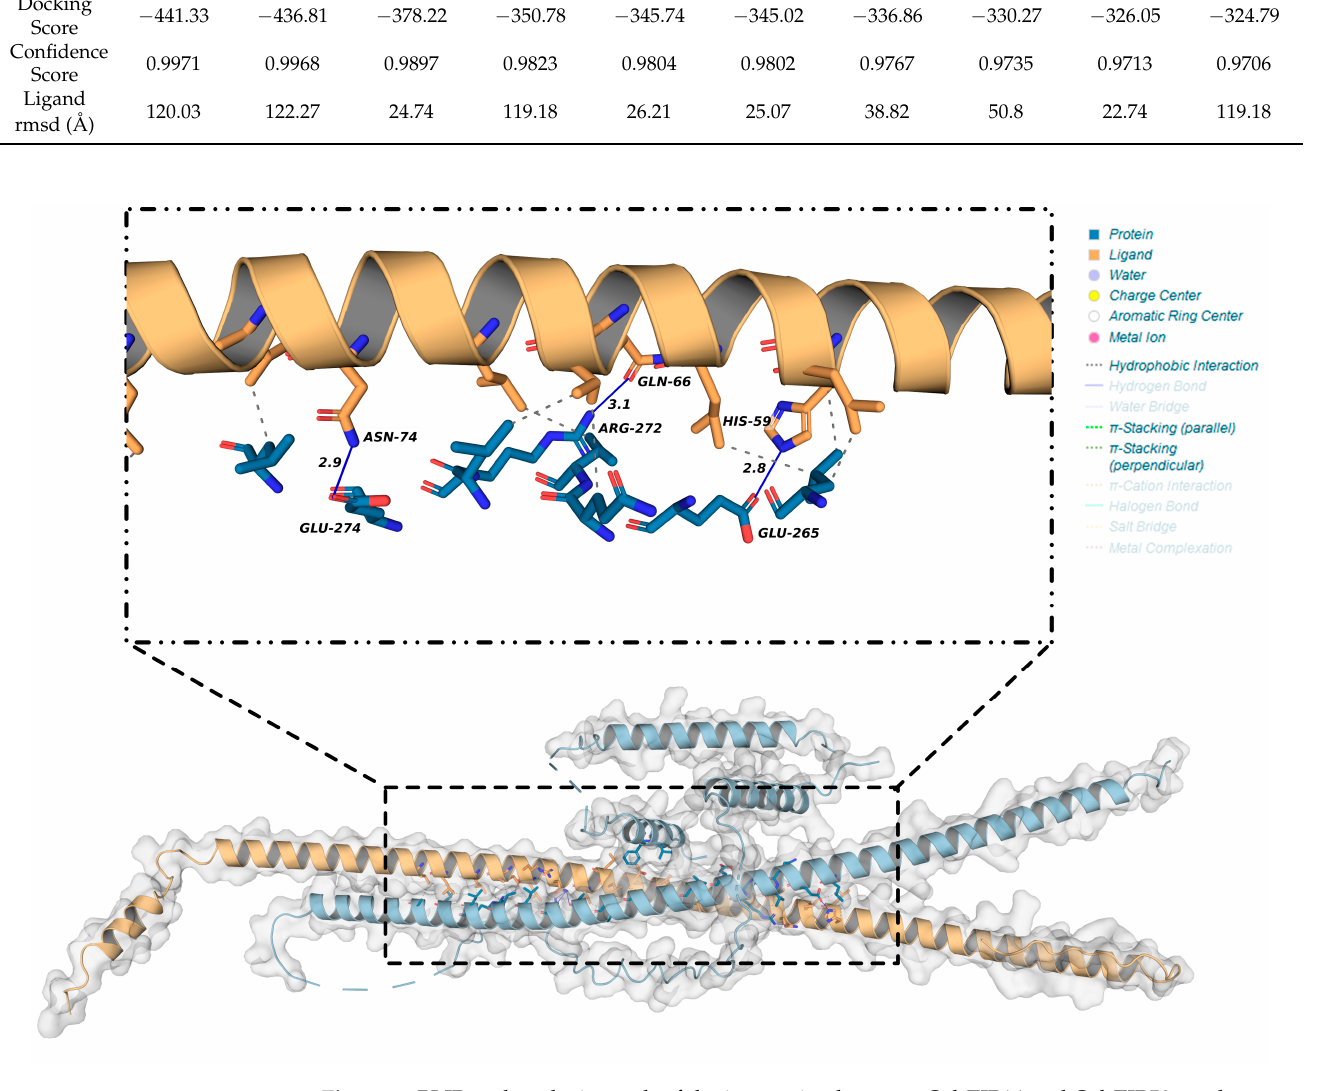
Figure 6. PLIP tool analysis result of the interaction between OsbZIP14 and OsbZIP58 products.